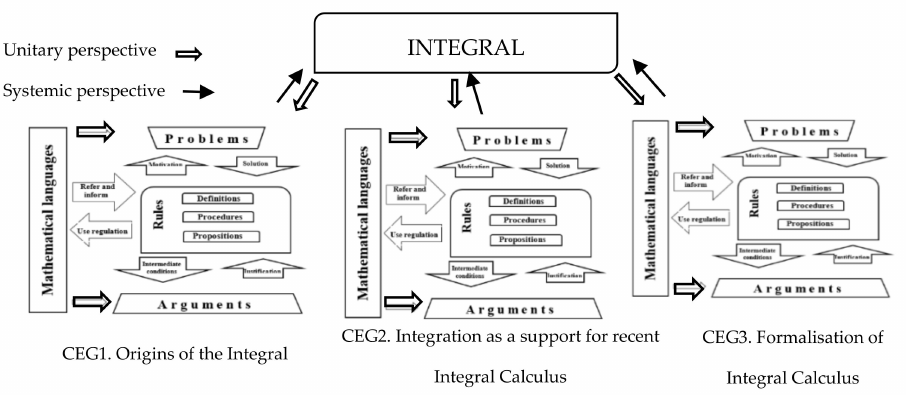
Figure 6. The integral object as a global